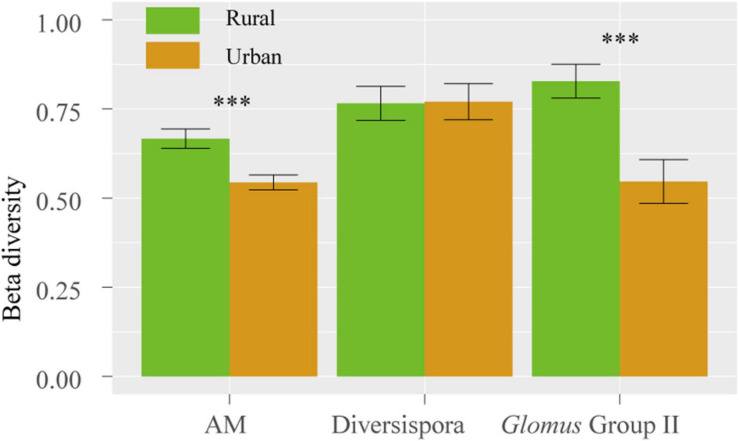
Dissimilarity of the fungal community among 8 host species in rural and urban areas. The vertical bars represent the standard error of the mean (n = 28). ***, LSD significant at the 0.001 level.